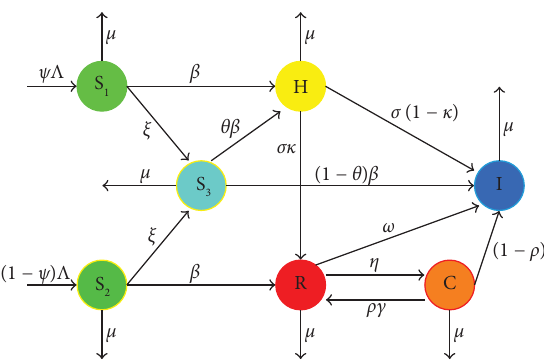
Figure 1: A schematic representation of the interactions between the